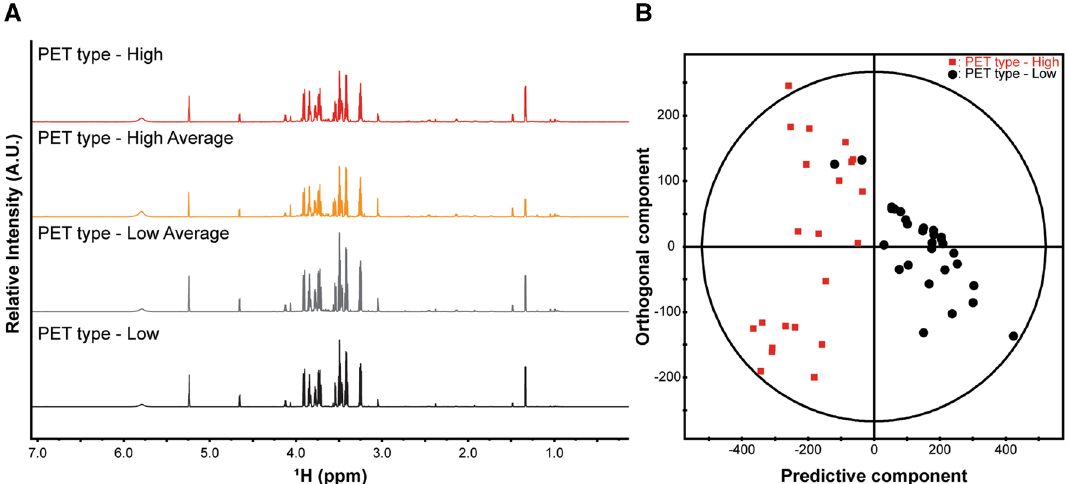
Figure 2. Representative NMR spectra obtained from overnight PD effluents and multivariate analysis between the PET types. ( A ) In total of 125 PD effluent samples were analyzed using 1D proton NMR spectra and representative samples from each group. A.U. stands for arbitrary unit, which is a relative unit of measurement used to show the intensity ratio in relation to a predetermined reference measurement. ( B ) OPLS-DA score plot derived from NMR spectra of overnight PD effluents between high and low PET types. OPLS-DA score plot showing the predictive component (X-axis) and the orthogonal component (Y-axis) of the model. The discrimination model was obtained with 1 predictive and 2 orthogonal components with the goodness of fit (R 2 ) of 0.737 and the predictability (Q 2 ) of 0.666. Each symbol represents the metabolic characteristic of a particular sample in the projected dimensions of predictive and 2 orthogonal components. The separation along the predictive component axis indicates the difference of interest (high versus low PET type) from the metabolic profile. OPLS-DA orthogonal projections to latent structure discriminant analysis, NMR nuclear magnetic resonance, PET peritoneal equilibration